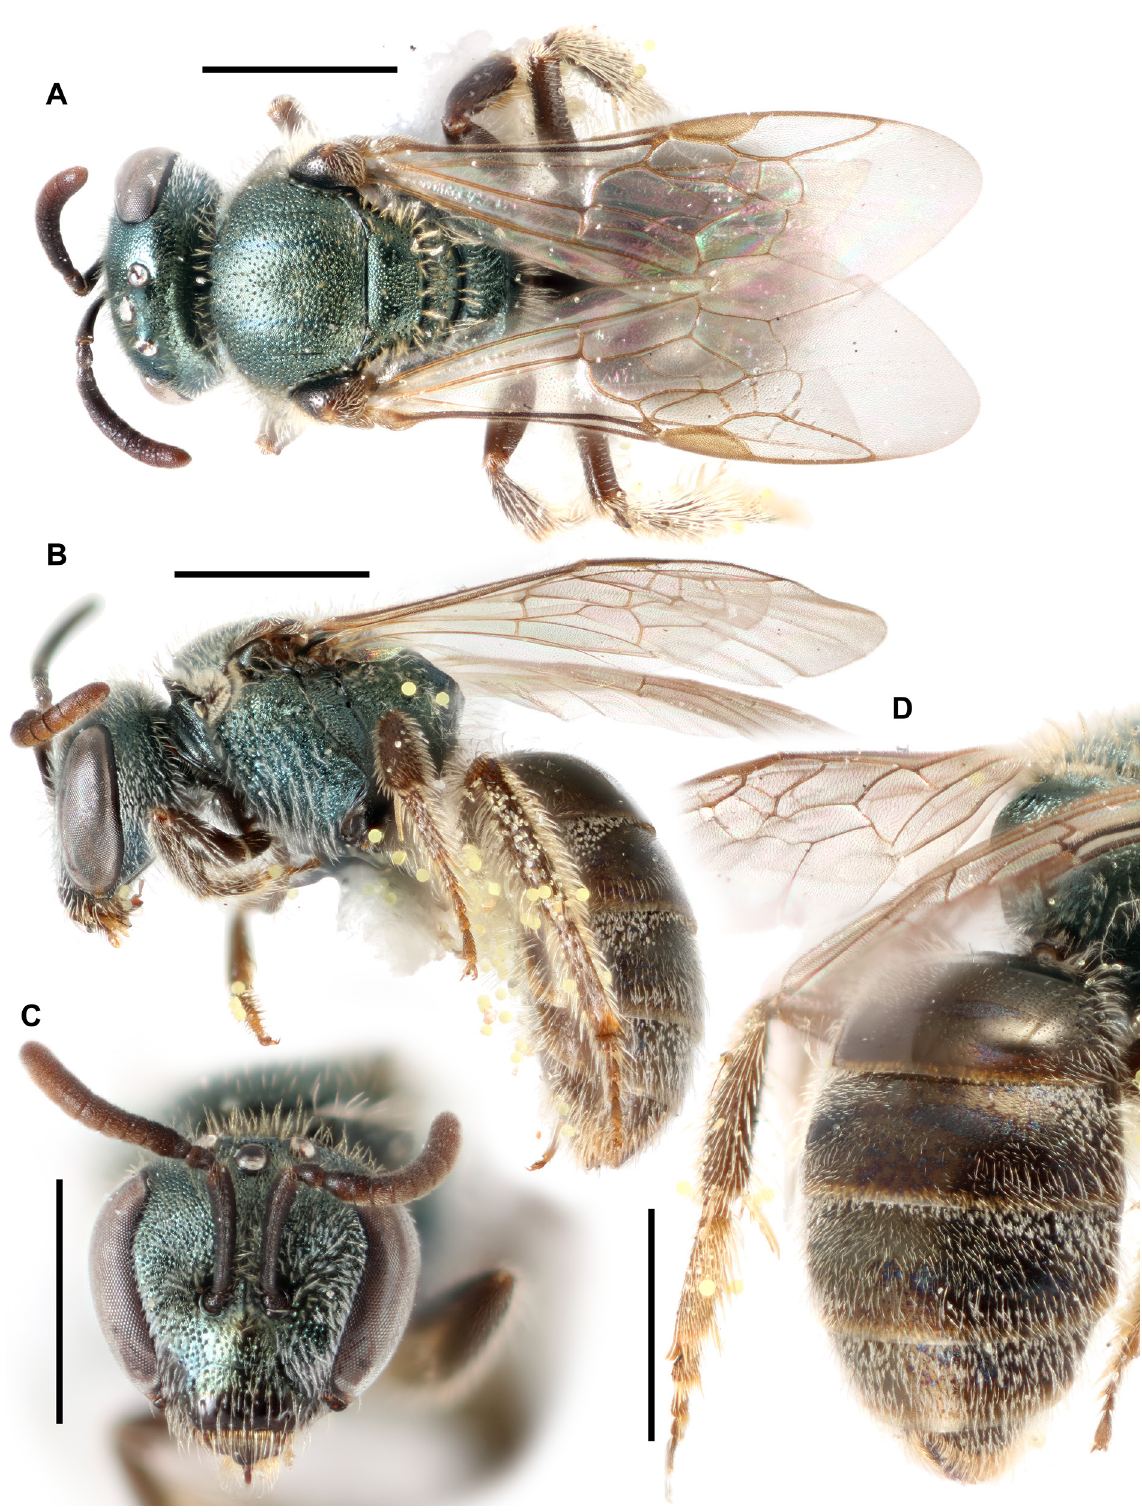
Fig. 70. Lasioglossum ( D .) tegulare (Robertson, 1890), ♀. A . Dorsal habitus. B . Lateral habitus. C . Face. D . Metasoma. Scale bars = 1